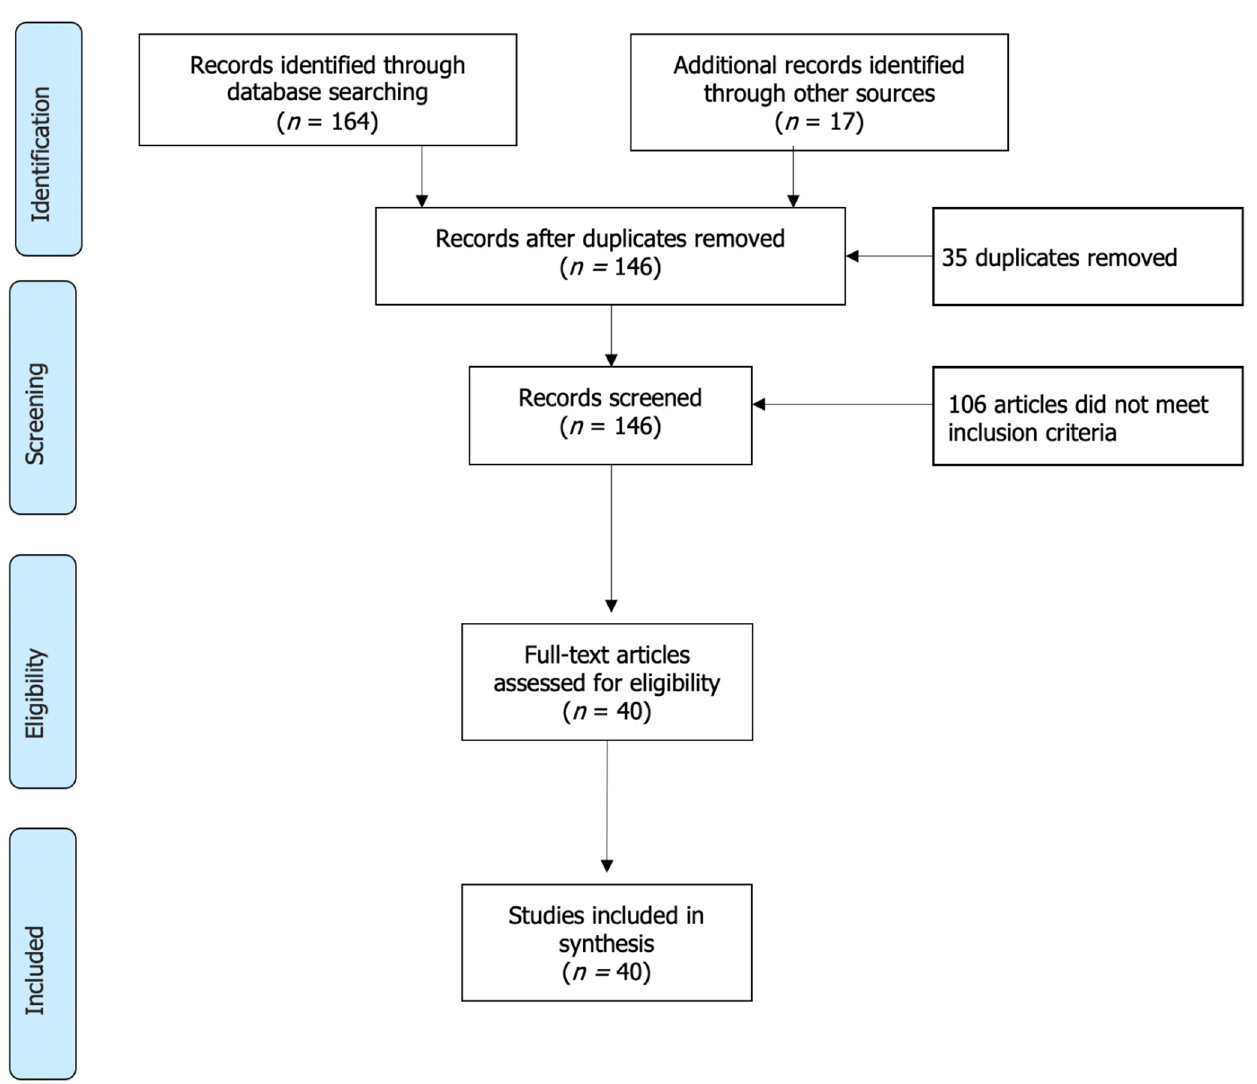
Figure 1. PRISMA flowchart illustrating the study selection process .